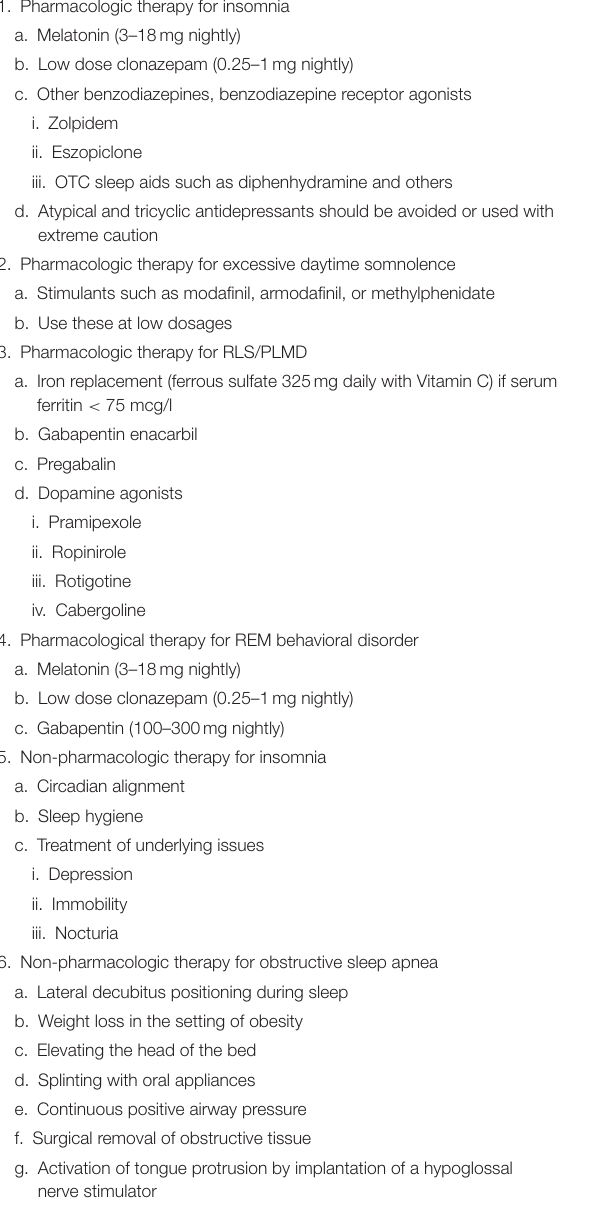
TABLE 7 | Management of sleep disturbances in